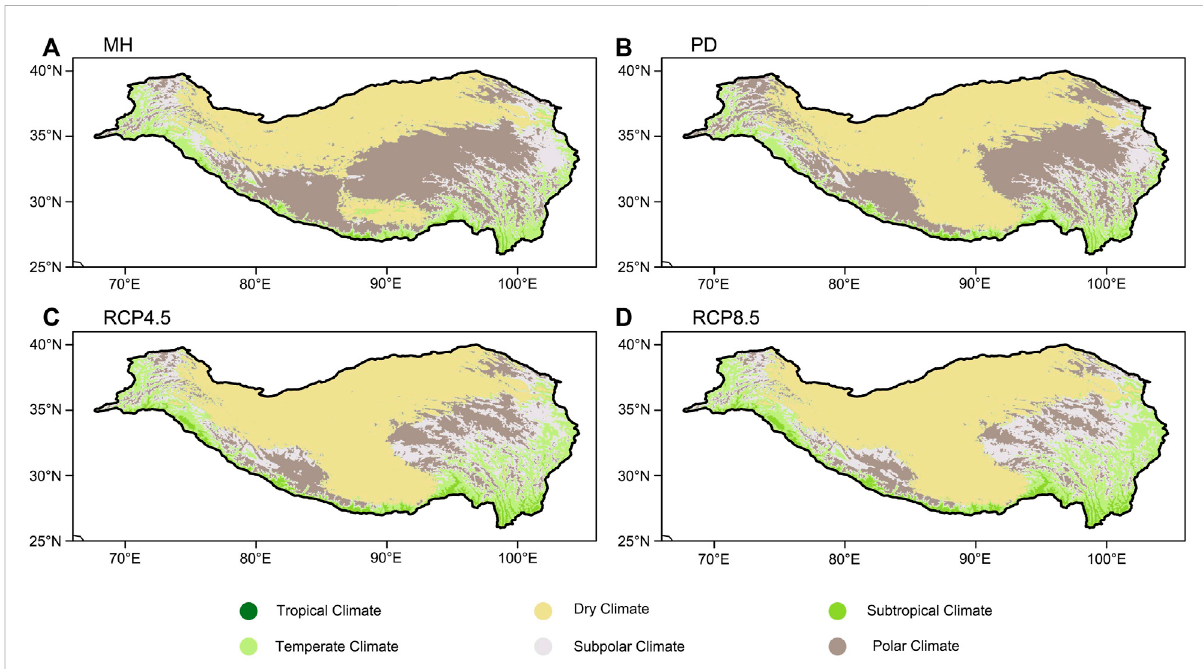
FIGURE 7 Distribution of major climate types (detailed information in Table 1) across TP. (A) MH, (B) PD, (C) RCP4.5, (D) RCP8.5.